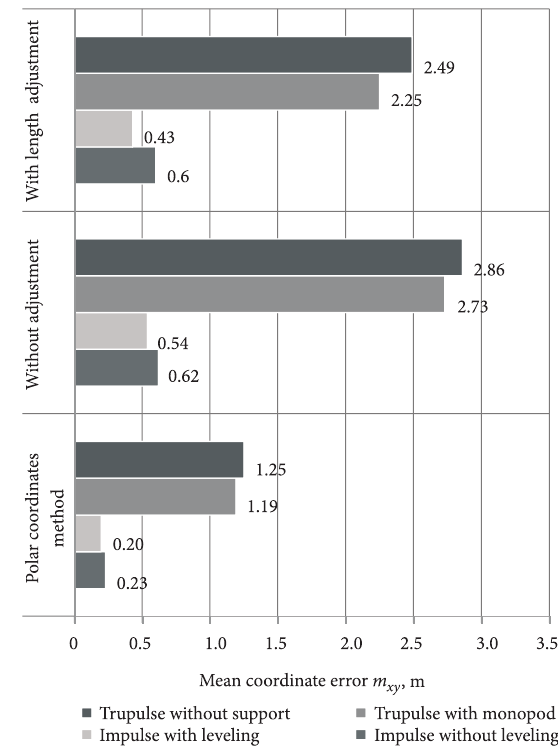
Fig. 3. Mean coordinate error values according to measurement and computation method